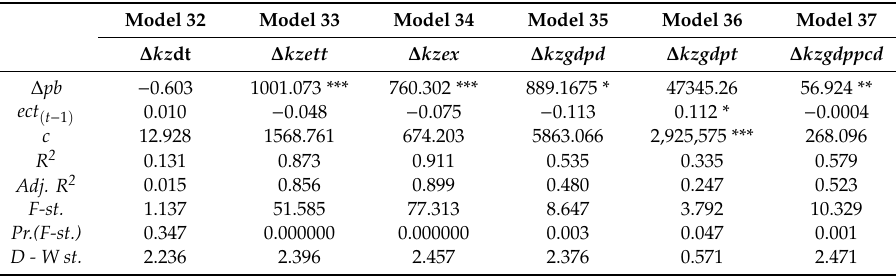
Table 6. The influence of oil price on macroeconomic indicators (Kazakhstan).